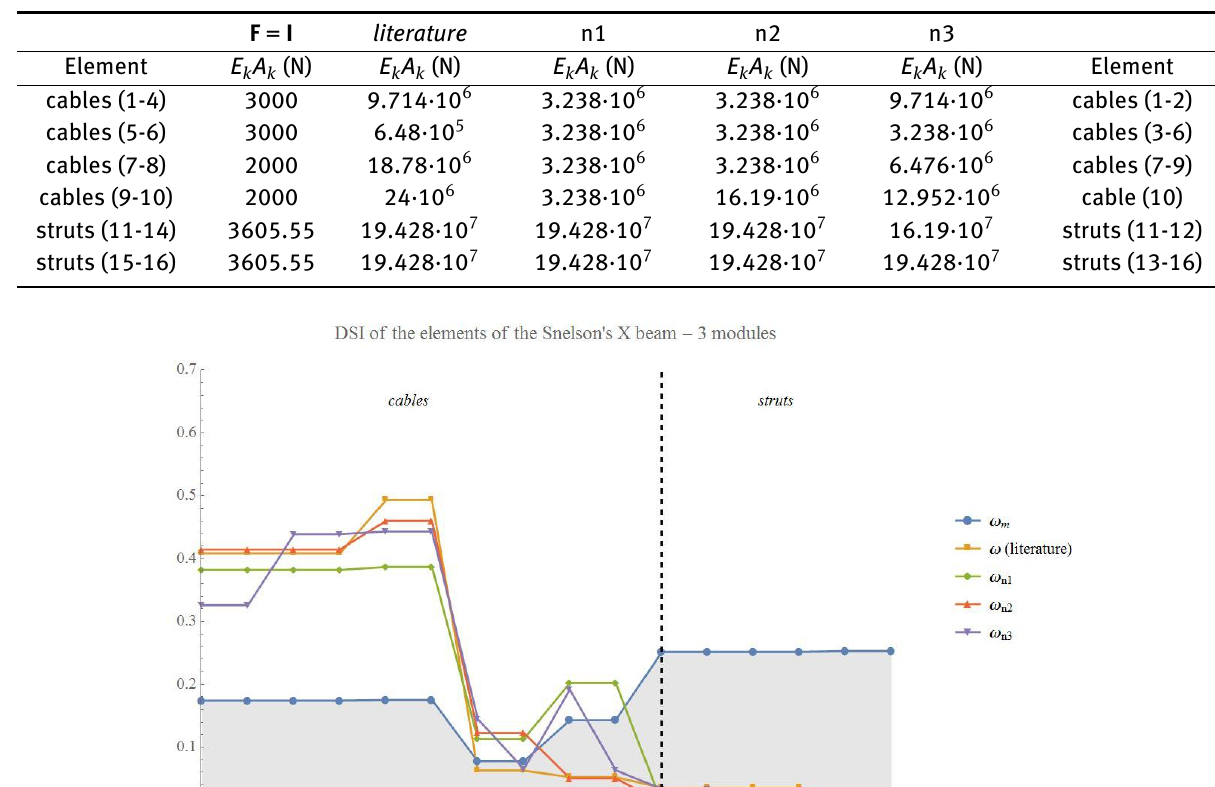
Table 3: Axial stiffness of the elements of the Snelson’s X beam with three modules